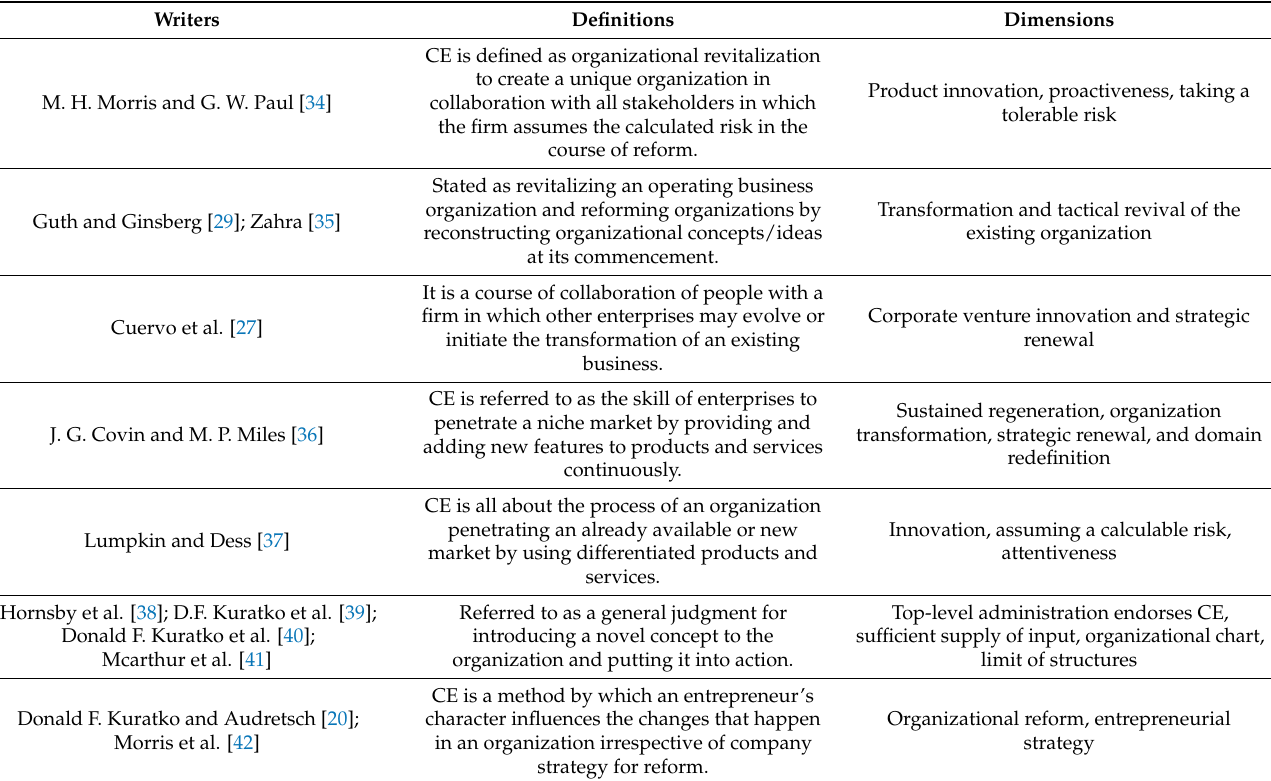
Table 1. Dimensions of CE with their